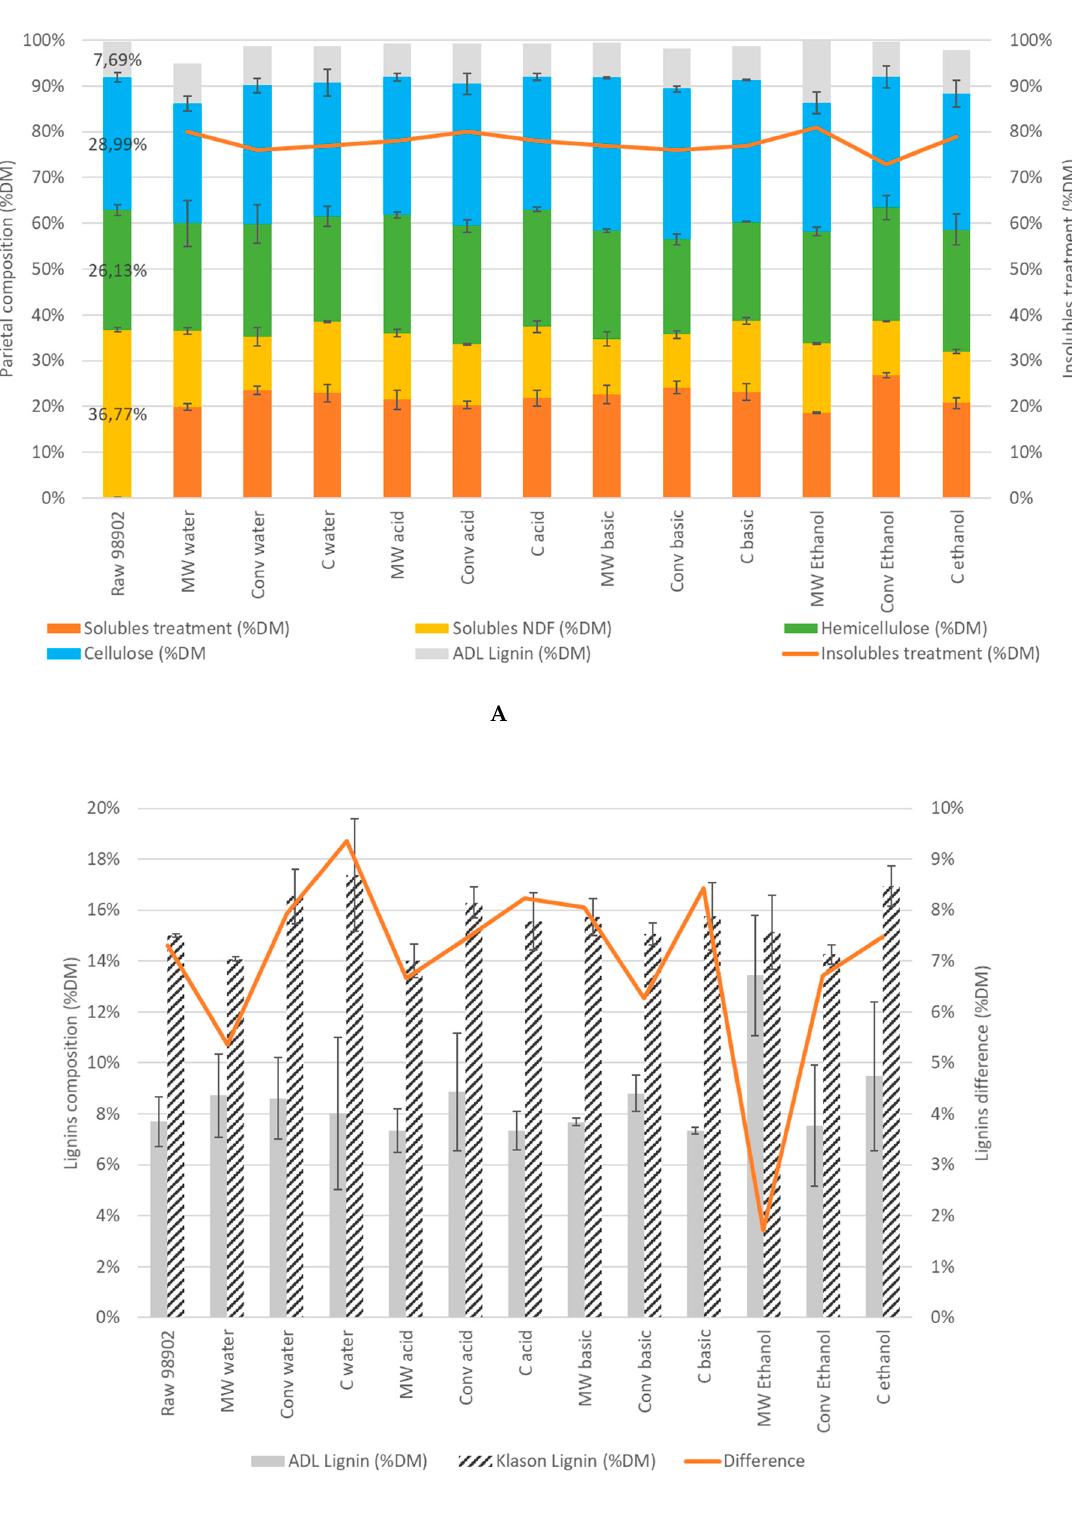
Figure 2. Biomass parietal composition depending on treatment (%DM) with Van Soest method ( A ). The figures in bold ( A ) are the percentages of insoluble content following the treatments (the mass of solid recovered after drying at 40 °C); the ash content is not represented. Comparison between Klason lignin and ADL ( B ). The figures in bold ( B ) are the di ff erences between the two lignins measurements. Means of